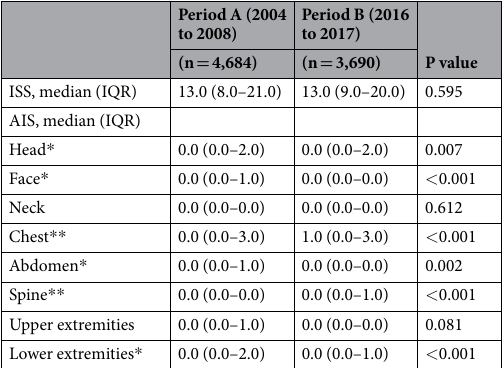
Table 2. Injury Severity Score (ISS) and Abbreviated Injury Scale (AIS) by body region in Period A versus Period B. * Median values were significantly higher in Period A than Period B. ** Median values were significantly lower in Period A than Period B.